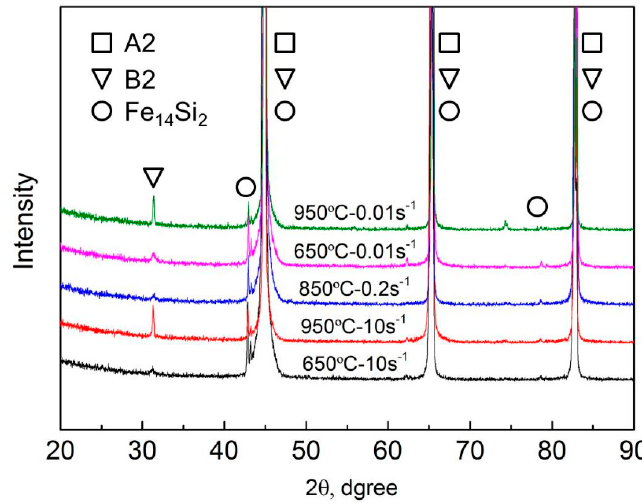
Figure 9. X-ray diffraction patterns of the Fe-6.5wt. %Si alloy after deformation at the true strain of 0.7.